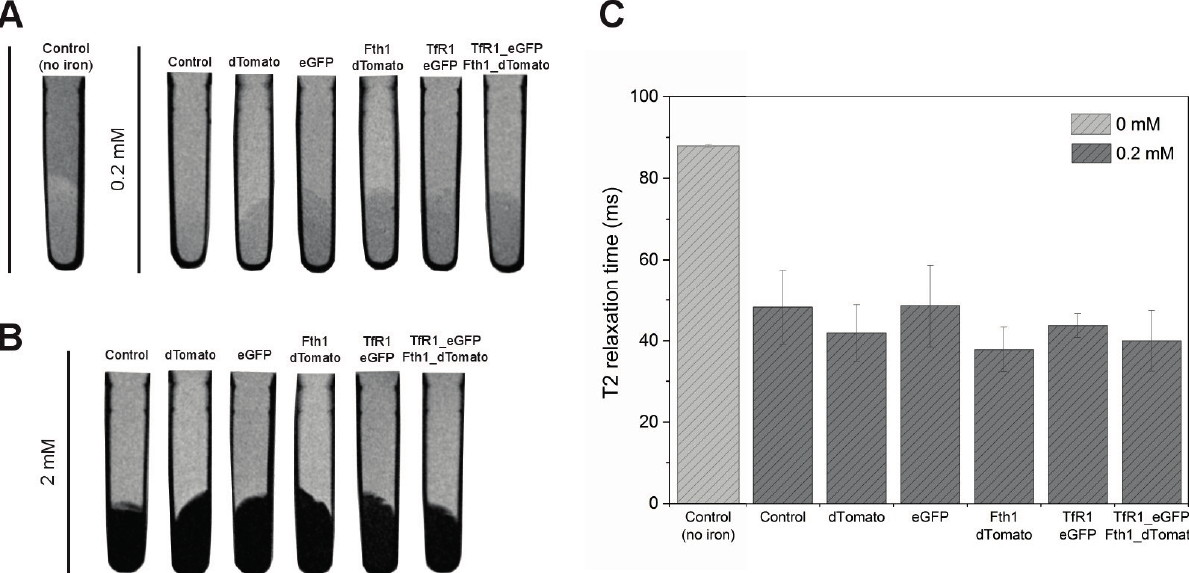
Figure 6. MR contrast of cells expressing TfR1 , Fth1 or a combination of these genes. MR images of cells ( A ) non-supplemented (0 mM) and supplemented with 0.2 mM or ( B ) supplemented with 2 mM of ferric citrate. Images obtained with a RARE T 2 -weighted sequence, repetition time = 5000 ms, echo time = 11 ms; ( C ) Relaxation time as measured from a region of interest in the area of the pellets shown in A